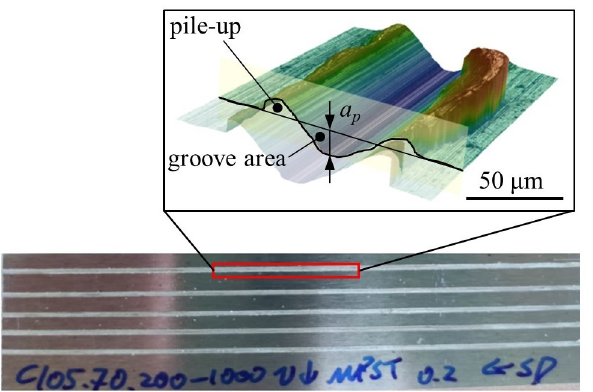
Figure 4. Scratches on A2024 T351 aluminum with pile-up and groove area.